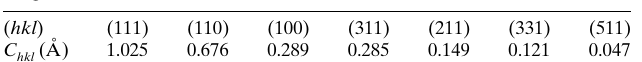
Table 3 Magnitudes of C hkl in